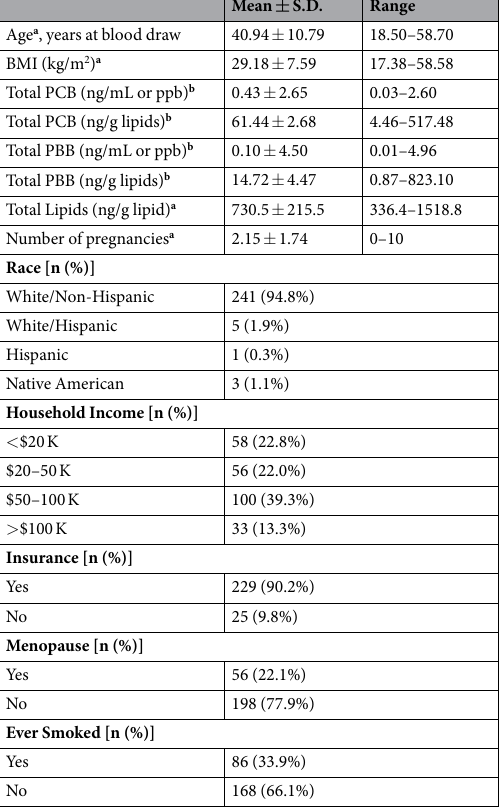
Table 1. Characteristics of women from the Michigan PBB Registry study of reproductive function (N = 254). a Arithmetic mean. b Geometric mean.